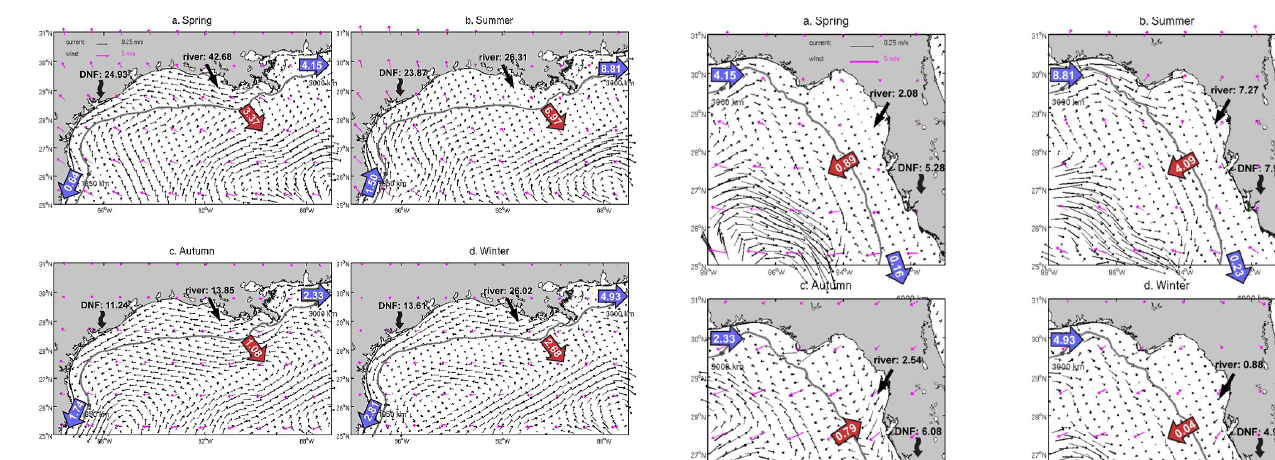
Fig. 15. Similar to Fig. 13 but for the LATEX shelf.